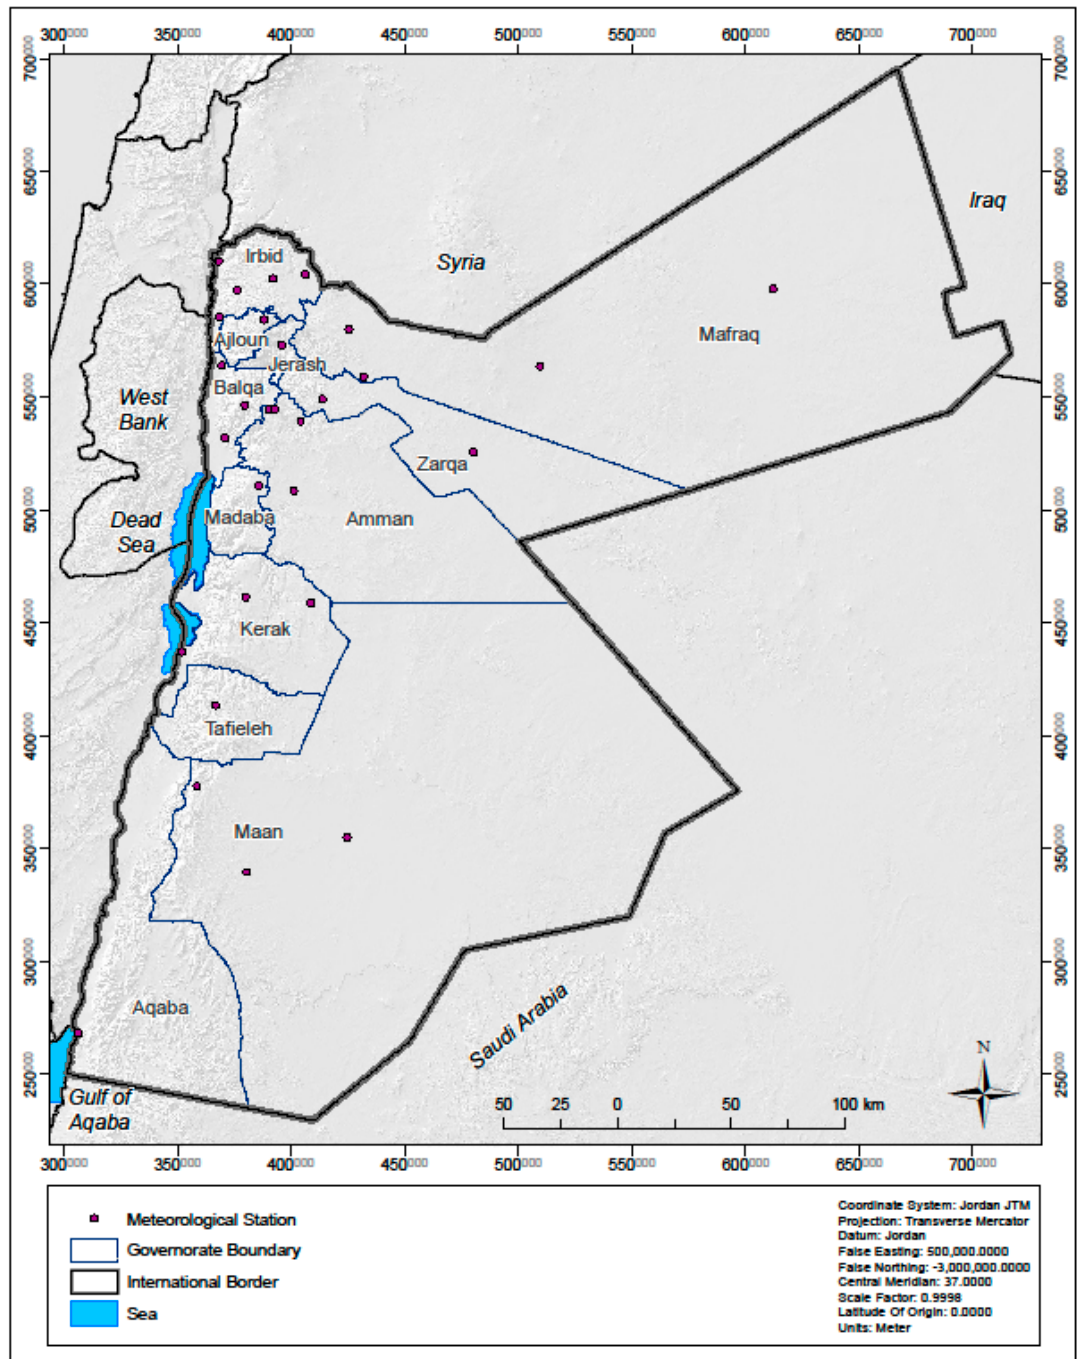
Figure 1. Hashemite Kingdom of Jordan as a study area.